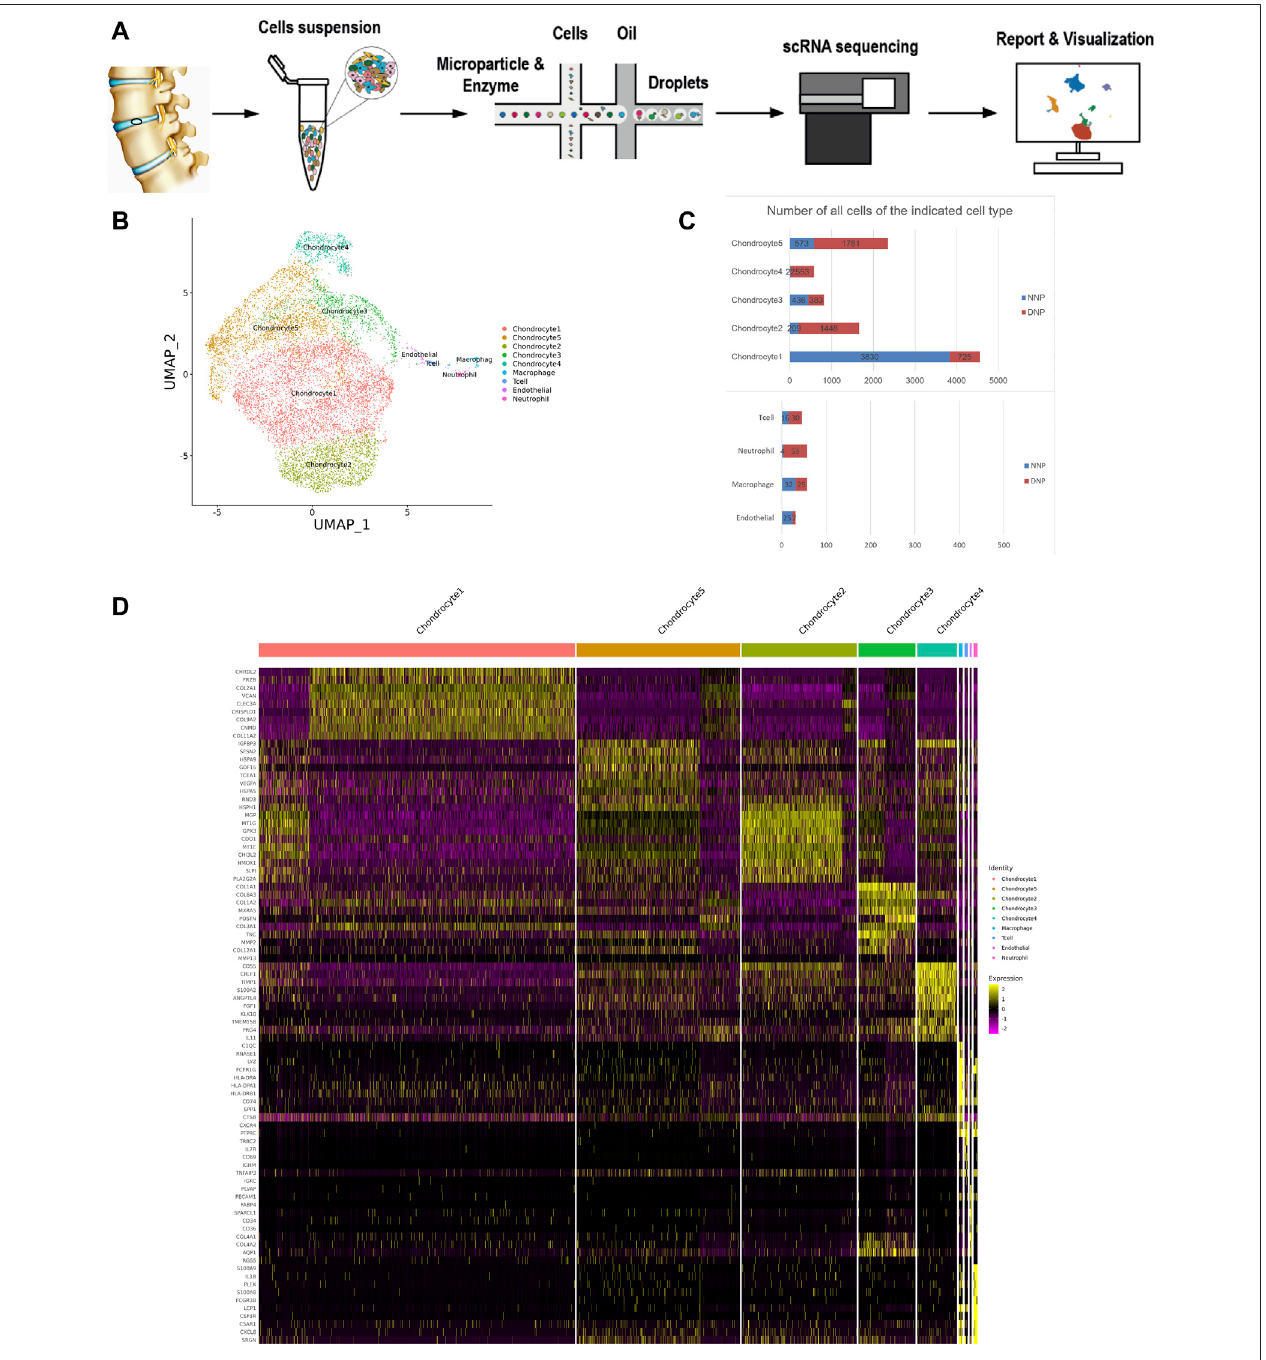
FIGURE 1 | ScRNA-seq cluster analysis of two nucleus pulposus (NNP + DNP) cells. (A) The work fl ow for collection and processing of nucleus pulposus specimensforscRNA-seq. (B) UMAPplotsof10152cells,showingtheninemajorcelltypesinnucleuspulposus. (C) Totalnumberofcellswithstackedcolumnchartfor speci fi ed cell type. (D) Heatmap showing and highlighting differentially expressed genes for each cluster.